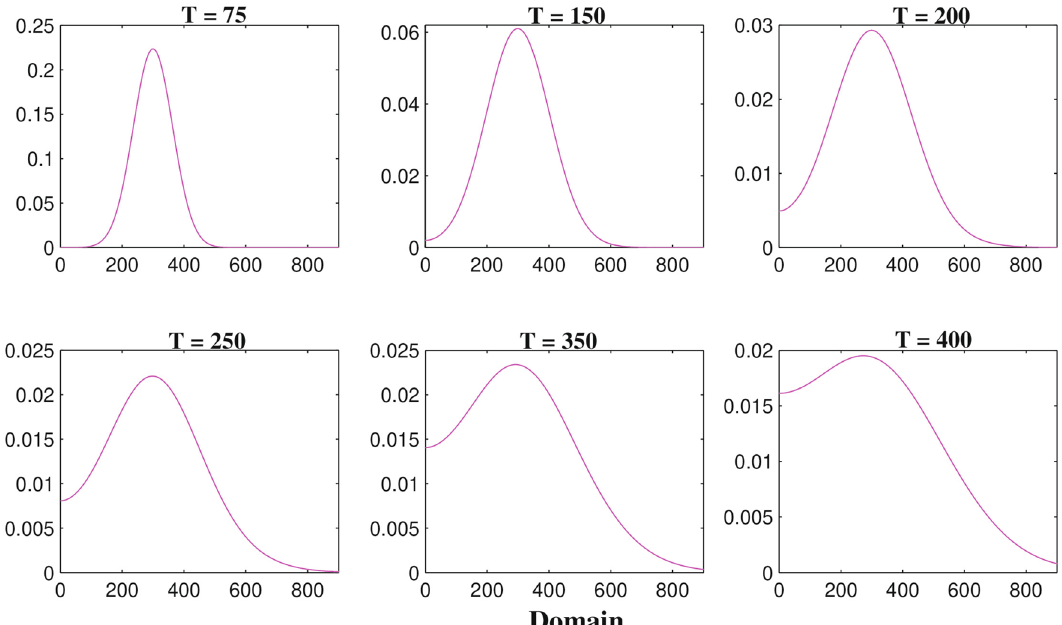
Figure 8. The one-dimensional numerical simulations describe the dynamics of cytotoxic T-lymphocytes density C T ( t , x , y ) at times corresponding to 75, 150, 200, 250, 350 and 400 h respectively. The simulation shows the migration of cytotoxic T-lymphocytes density through the domain for an increasing value of time. Parameter values: D G = 55 , D M = 5 , D T = 400 , D C = D I = 25 and the other parameter values and initial conditions are presented in the Table 1.